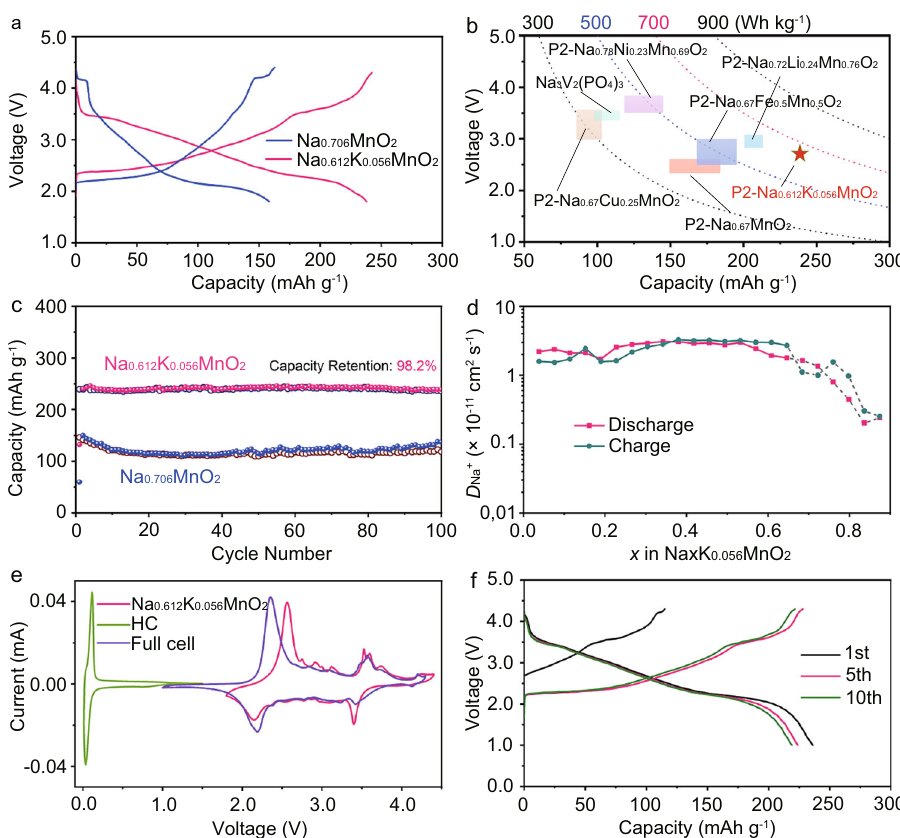
Fig. 6 Electrochemical performance. a Typical charge/discharge curves of Na 0.612 K 0.056 MnO 2 and Na 0.706 MnO 2 at 20 mA g − 1 in the third cycle. b Comparison of energy density and average voltages of Na 0.612 K 0.056 MnO 2 with typical cathode materials in refs. 38 – 45 . c Cycle performance of Na 0.612 K 0.056 MnO 2 and Na 0.706 MnO 2 at 50 mA g − 1 . d Variation of D Na + as functions of x in Na x K 0.056 MnO 2 determined by GITT and CV, where the gray dotted area represents the two-phase region. e CV curves of Na 0.612 K 0.056 MnO 2 , HC and the full battery of HC//Na 0.612 K 0.056 MnO 2 at 0.1 mV s − 1 . f Typical charge/discharge curves of HC//Na 0.612 K 0.056 MnO 2 at 50 mA g − 1